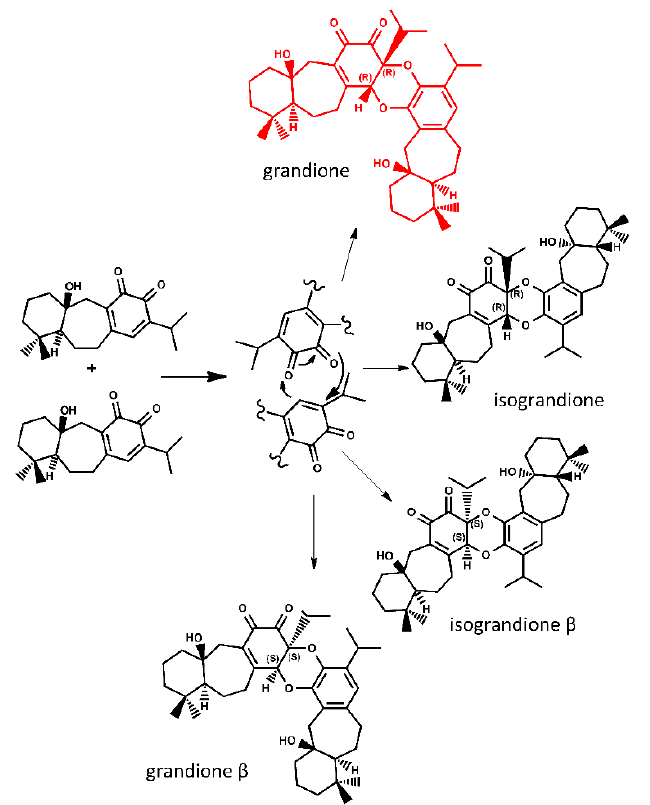
Figure 1. Biosynthetic mechanism for formation of the icetexane dimer grandione proposed in the literature [24,25].